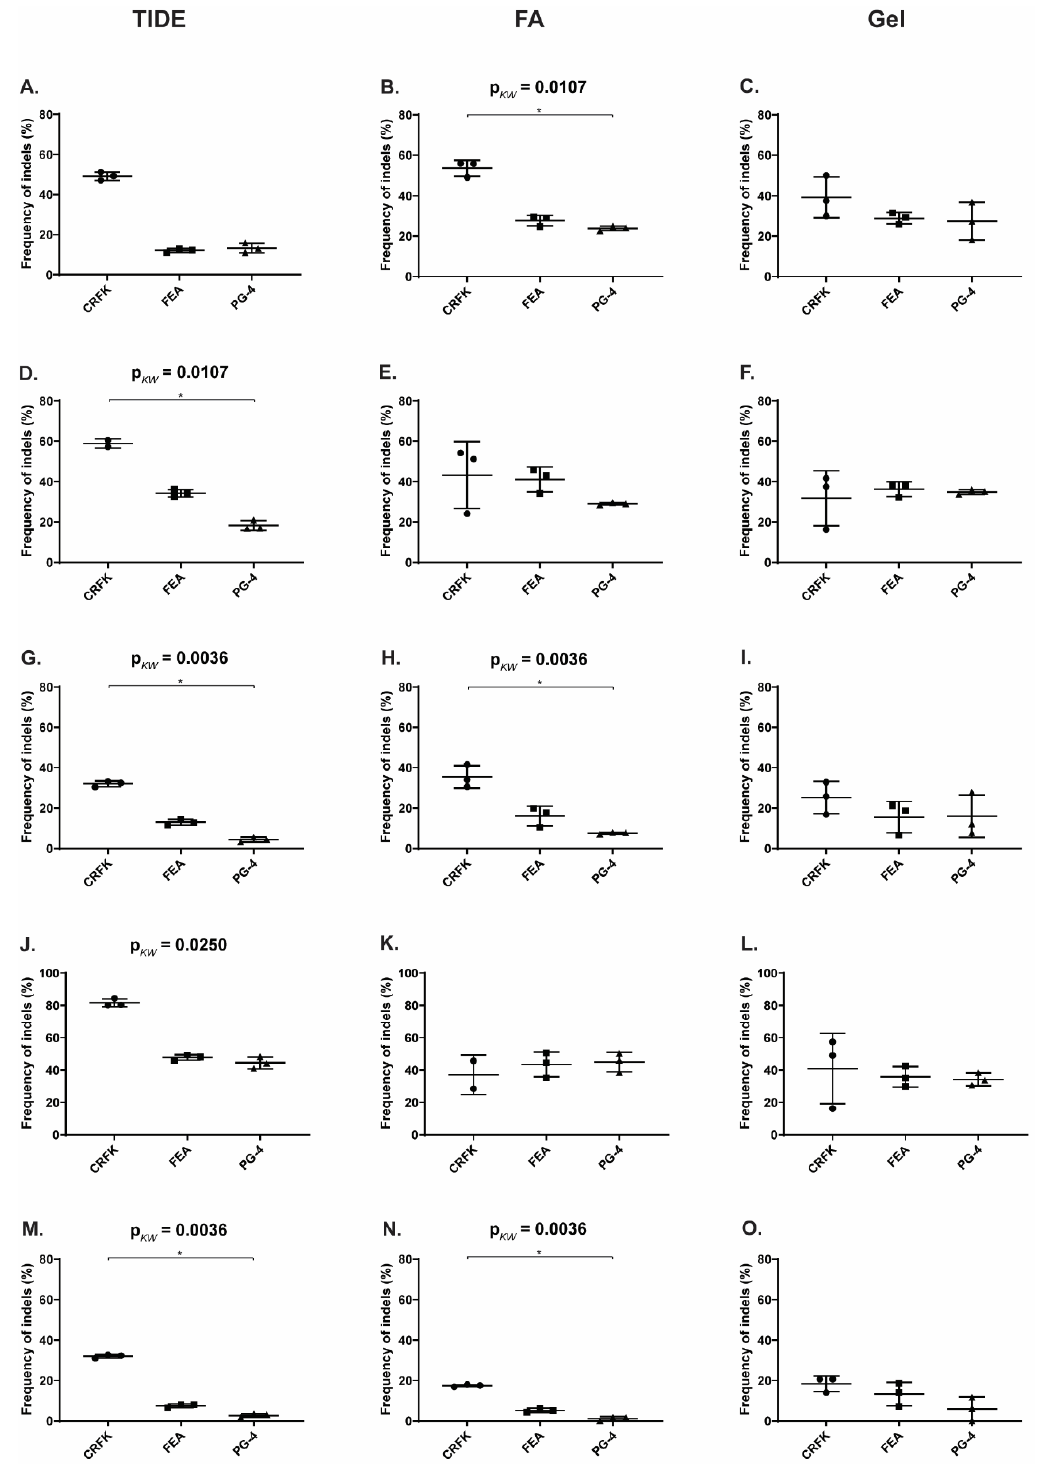
Figure A5. Comparison of CRISPR/ Sa Cas9 activity between cell lines. After CRISPR/ Sa Cas9 transduction using the AAV-DJ vectors, the frequency of indels (%) was compared between the cell lines. Each raw corresponds to one Target: graphs ( A – C ) to Target 4 (vKHH1); ( D – F ) to Target 5 (vKHH3); ( G – I ) to Target 6 (vKHH4); ( J – L ) to Target 8 (vKHH2); and ( M – O ) to Target 10 (vKHH5). The graphs ( A , D , G , J , M ) represent results determined by TIDE; ( B , E , H , K , N ) by T7E1 using the fragment analyzer (FA); ( C , F , I , L , O ) by T7E1 quantifying signal intensity on a gel. Frequency of indels (%) was tested for significant differences by Kruskal–Wallis, one-way ANOVA by ranks (p KW as indicated), and subsequently by Dunn’s post-test: * = p < 0.05. The data are shown as scatter dot plots. The horizontal line represents the mean with SD.